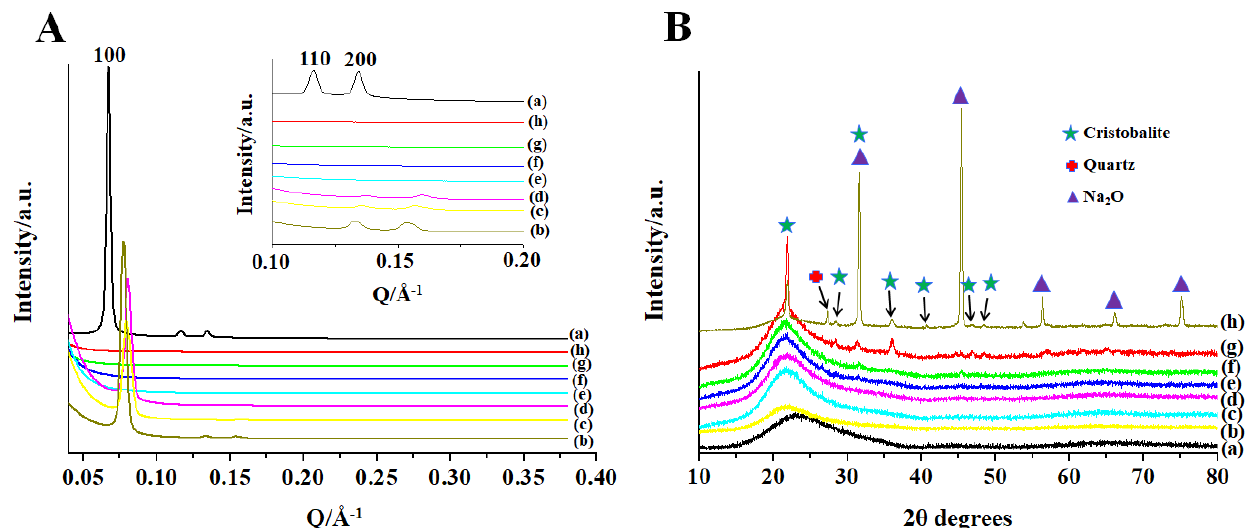
Figure 1. SAXS ( A ) and XRD ( B ) patterns of (a) SBA-15, (b) SBA15-Na-80-700, (c) SBA15-Na-60-700, (d) SBA15-Na-50-700, (e) SBA15-Na-40-700, (f) SBA15-Na-30-700, (g) SBA15-Na-20-700 and (h) SBA15-Na-2.1-700. Inset in Figure 1A shows the magnified SAXS patterns in the q = 0.10 – 0.20 ranges for samples.